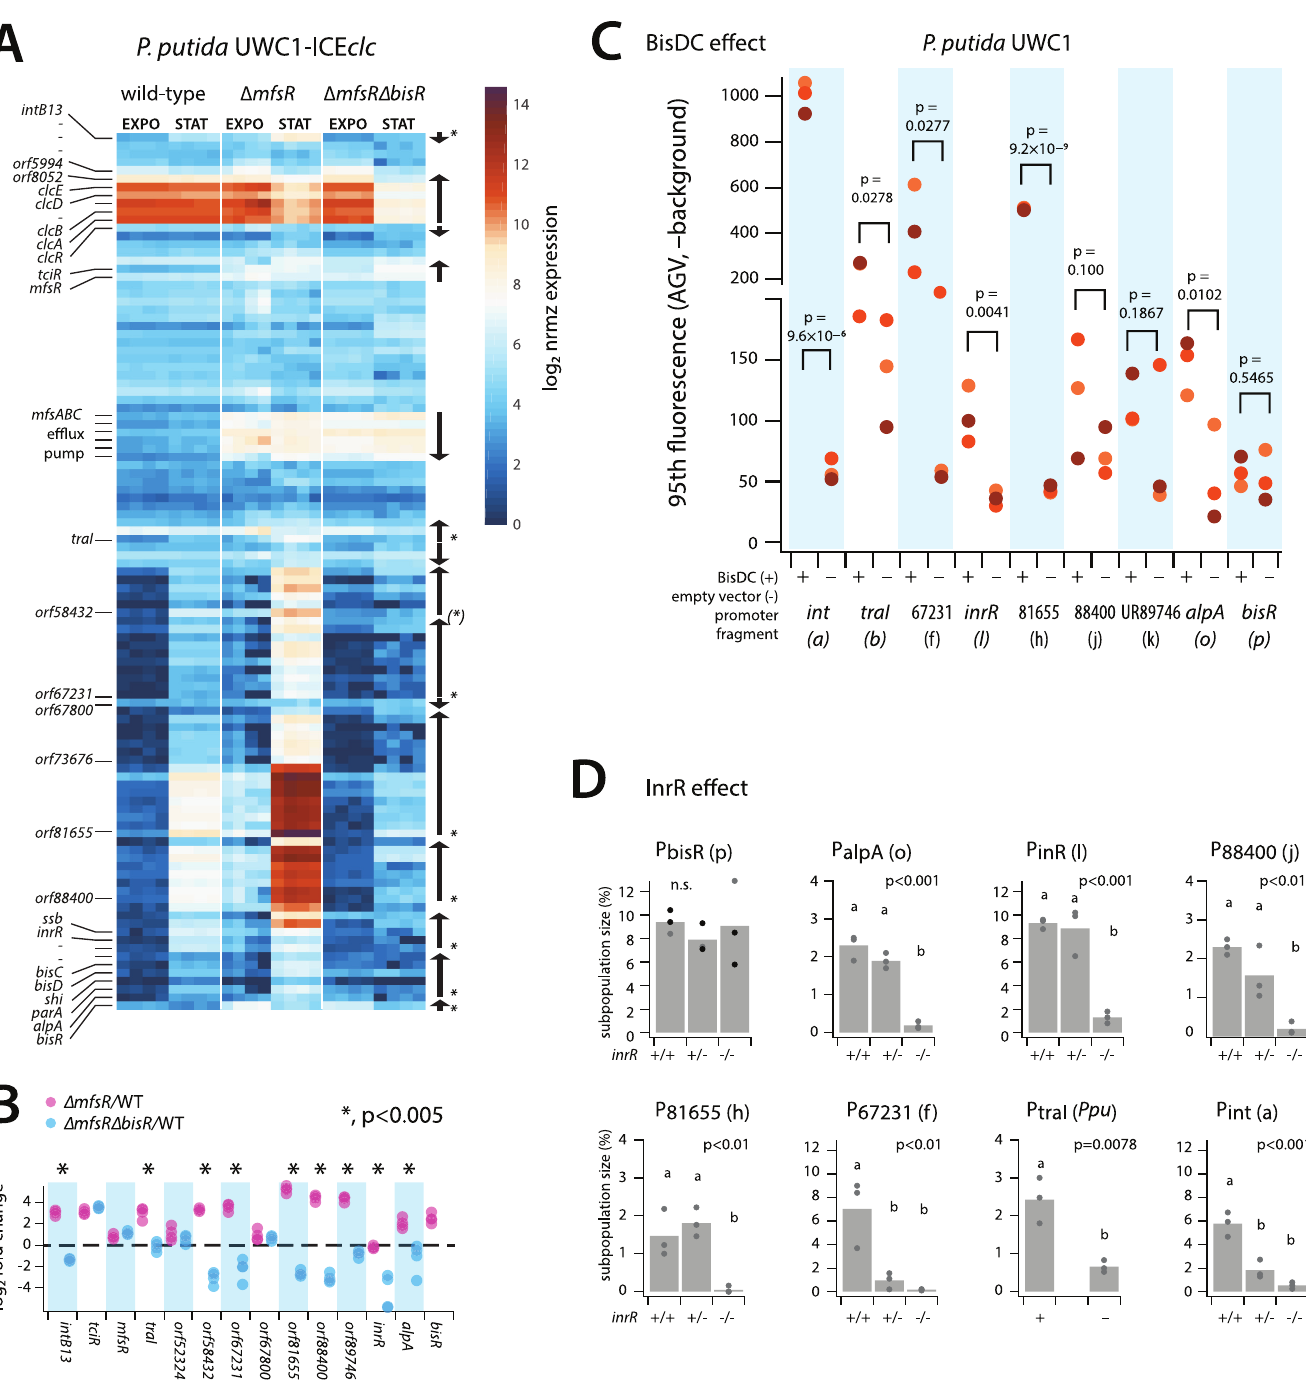
Fig 6. Dependency of ICE clc promoters on ICE global regulators initiating transfer competence. A Log 2 -scaled normalized and per-gene attributed read counts from RNA-seq of P . putida carrying wild-type ICE clc , Δ mfsR or Δ mfsR Δ bisR deletions, for the ICE clc gene region ( intB13 gene on top; bisR at bottom). Each colored rectangle corresponds to a single gene (relevant names on the left) and replicate (four replicates per condition and strain; growth on 3CBA, sampled in exponential phase and late stationary phase). Organisation of transcriptional units depicted with arrows on the right (asterisks corresponding to those being part of the transfer competence regulon, role of P 58432 inconclusive). B Calculated log 2 -fold changes between mutant and wild-type ICE clc for the tested promoter regions and controls. Dots corresponding to individual replicate values. Dotted line represents ratio of 1. Asterisks denote statistically significant differences in mattest with bootstrapping (n = 1000). Note that reads could not be mapped to bisR in the corresponding deletion mutant. C Effect of induction of plasmid-located bisDC (+) on reporter fluorescence of P . putida without ICE clc with indicated single copy inserted promoter- or control (UR89746) fusions. Cells sampled in stationary phase after growth on succinate. Comparisons are the same P . putida reporter strains but with empty plasmid (–). Plotted is the 95 th percentile scaled fluorescence (minus image